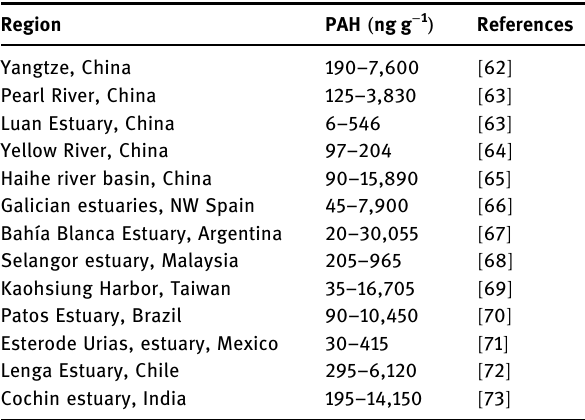
Table 2: A comparative study of PAHs along the estuarine coastal system other than Red Sea and Arabian